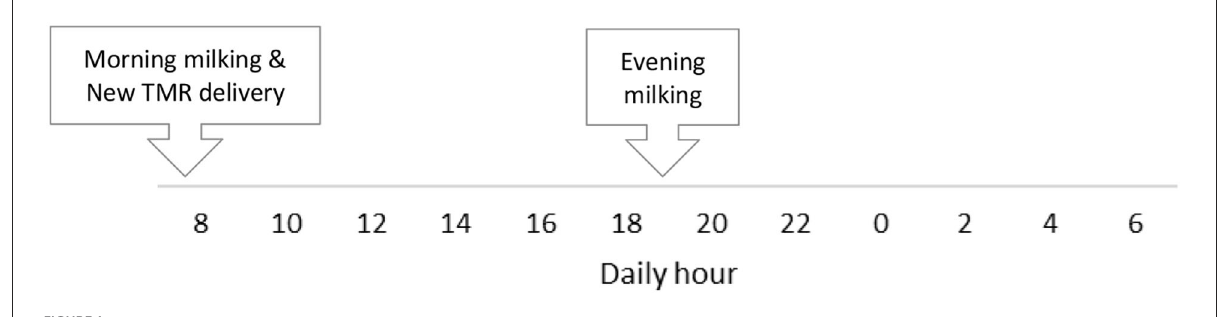
FIGURE1 Farm daily routine implemented during the trial.